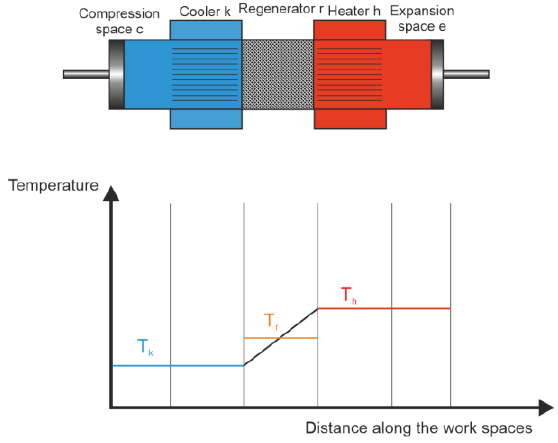
Fig. 7. Temperature profile in workspaces for isothermal model [23]